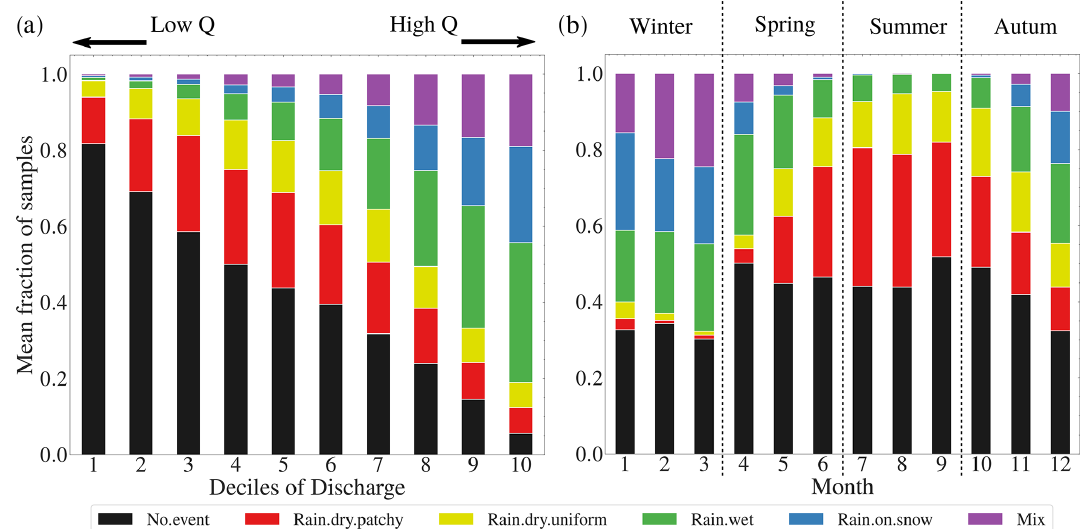
Figure 4. (a) Mean fraction of samples linked to each event type according to each catchment decile of discharge, and (b) seasonal distribution of mean fraction of samples linked to each event type in the study catchments.